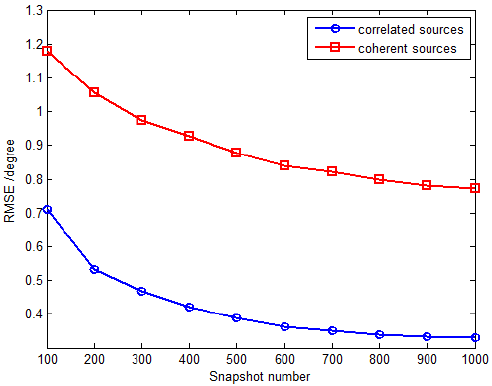
Figure 11. RMSE versus snapshot number with fixed SNR 15 dB.